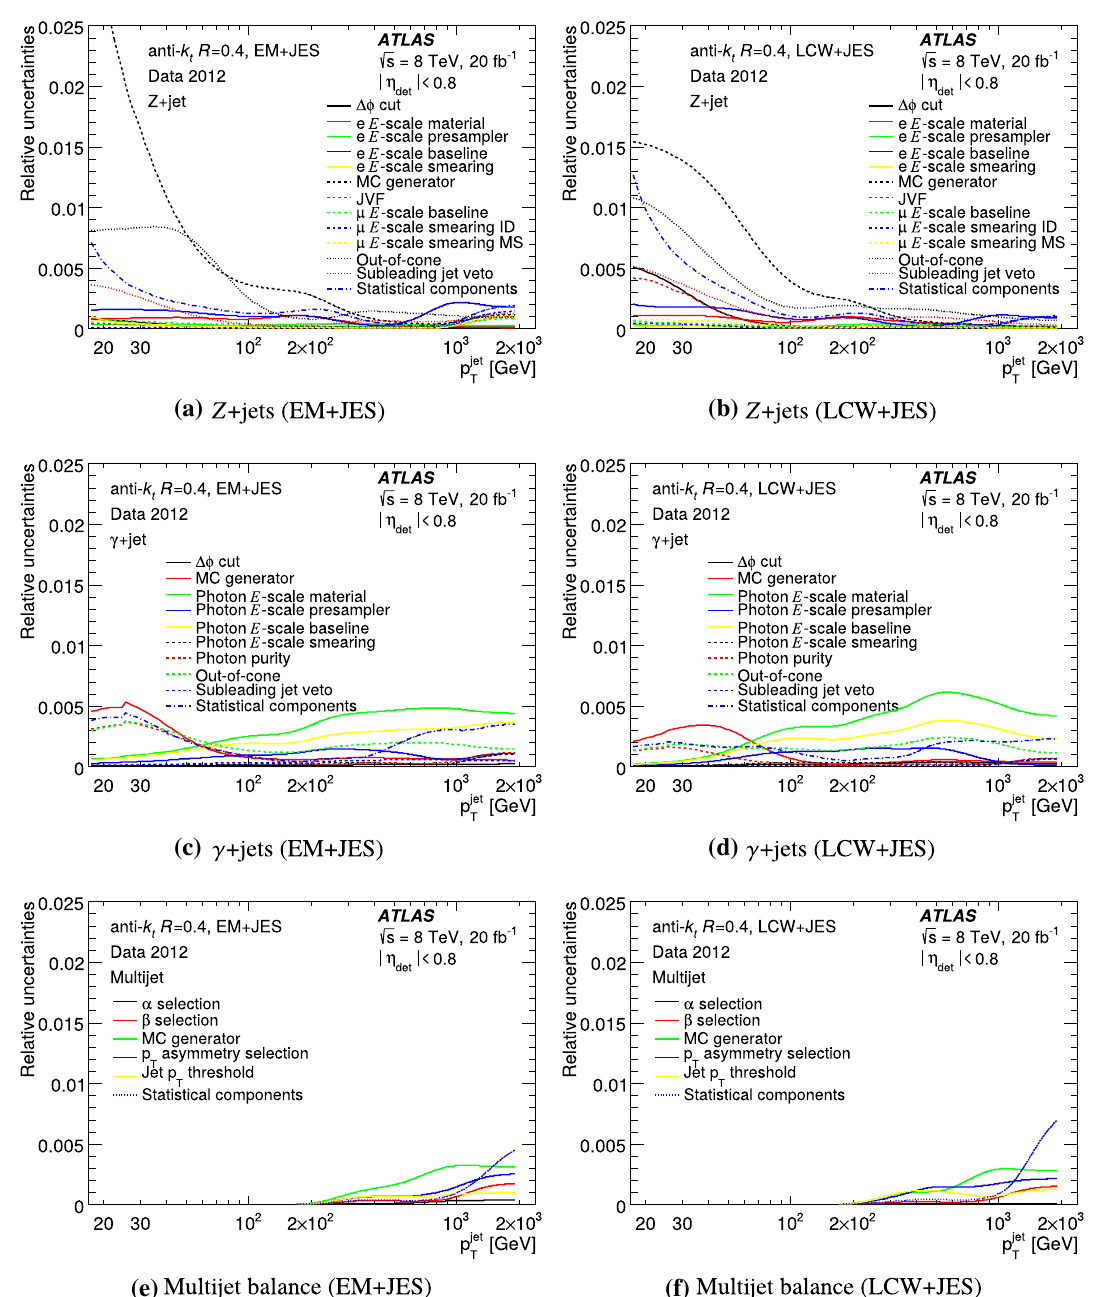
Fig. 40 Individual uncertainty sources used in the combination for the three absolute in situ calibration methods. The systematic uncertainties displayed correspond to those in Table